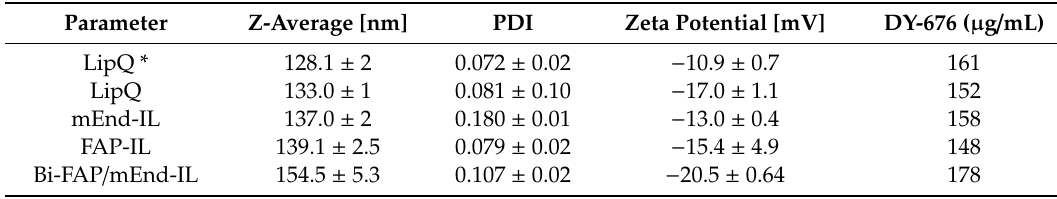
Table 1. Properties of dye-loaded activatable liposomes.